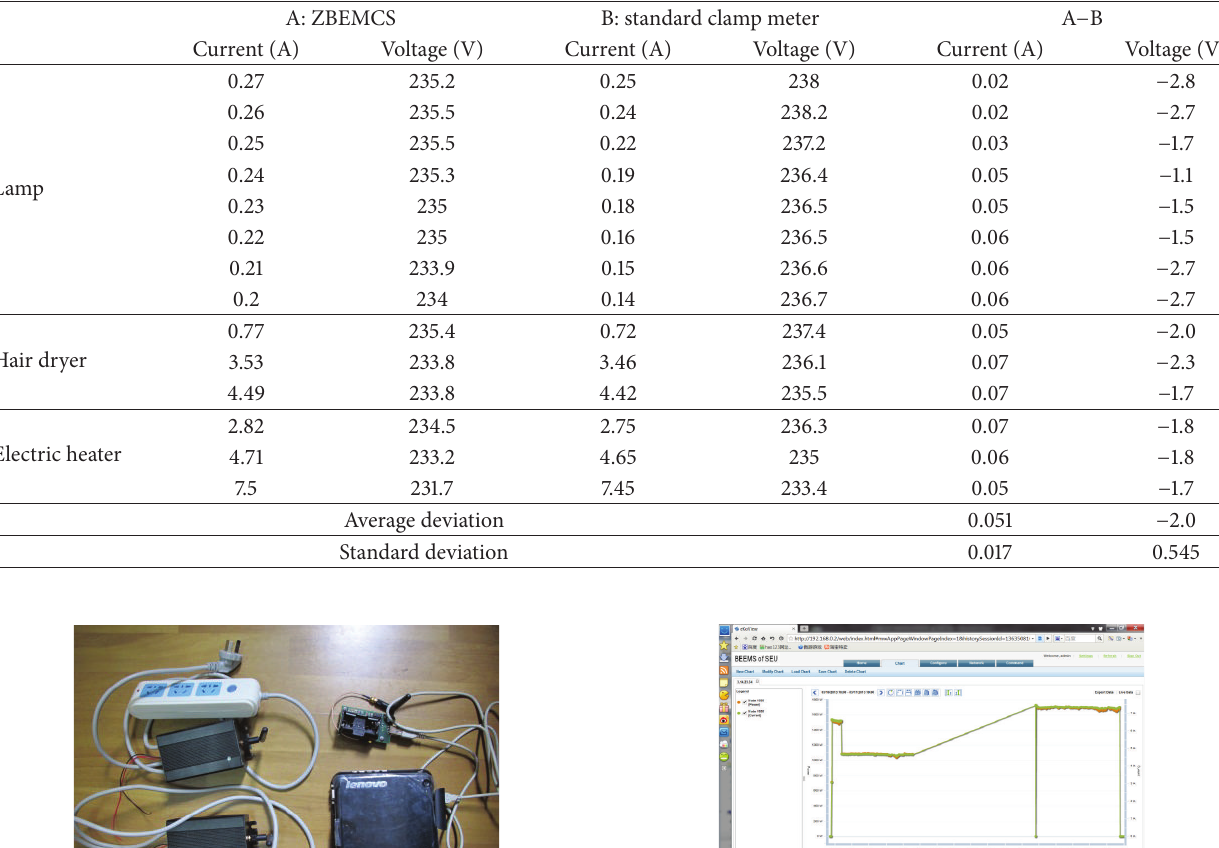
Table 2: Current and voltage data comparison between the ZBEMCS and a standard clamp meter.